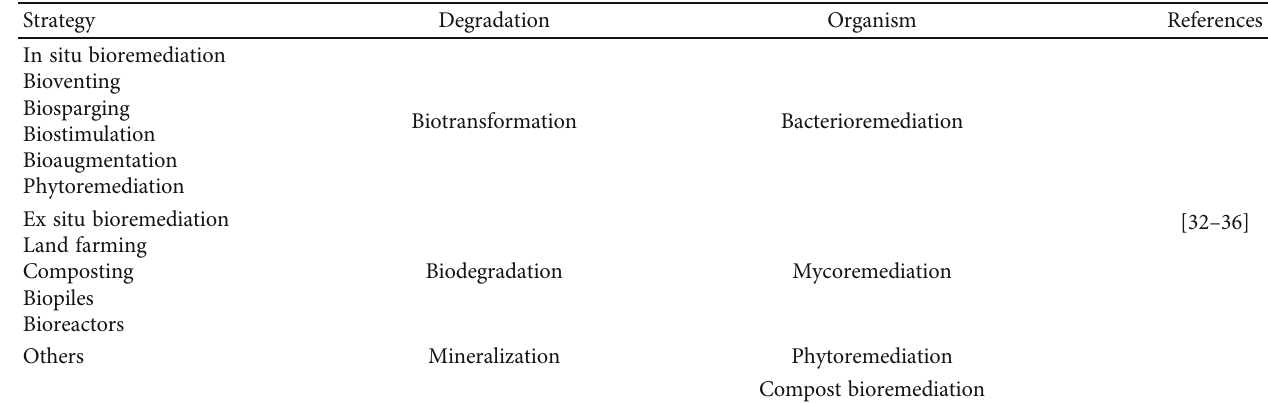
Table 1: Types of